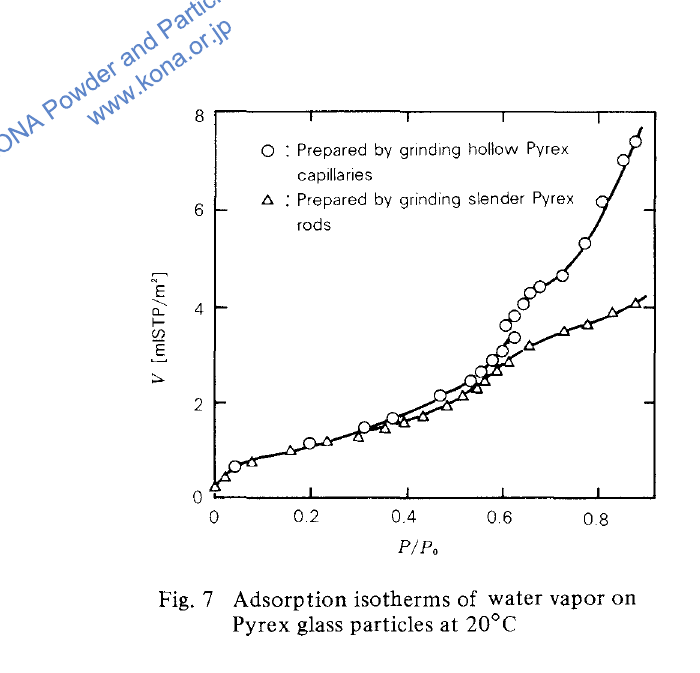
Fig. 7 Adsorption isotherms of water vapor on Pyrex glass particles at 20°C